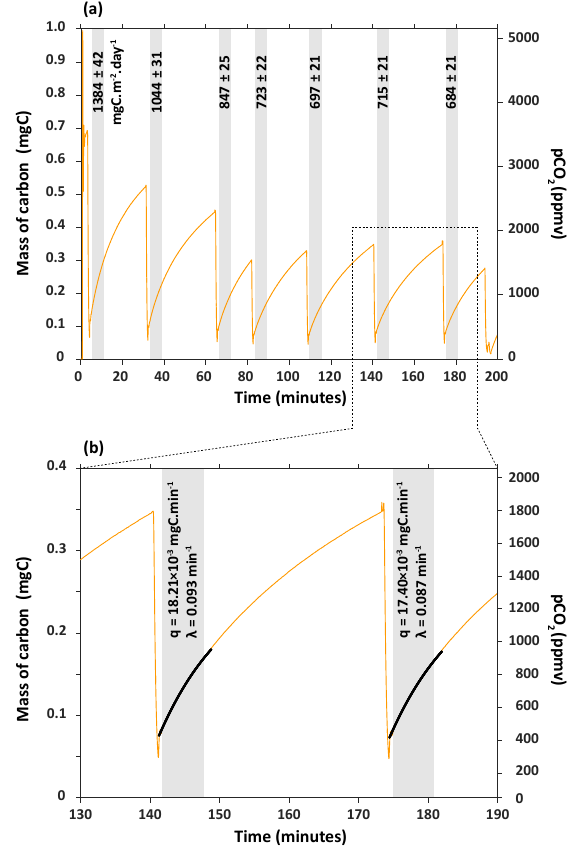
Figure 3. (a) Series of carbon flux measurements for chamber H6 on 27 March 2017. CO 2 concentration ( p CO 2 ) was converted into mass of carbon (mgC) following Eqs. (1) and (2). Flux of CO 2 – the numbers associated to shaded boxes – are given in milligrams of carbon per square metre per day (mgCm − 2 day − 1 ). (b) Close-up of how fluxes were calculated from the rate of carbon accumulation (parameter q ) by fitting the exponential model described in Eqs. (4) and (5) for 6min (shaded box).